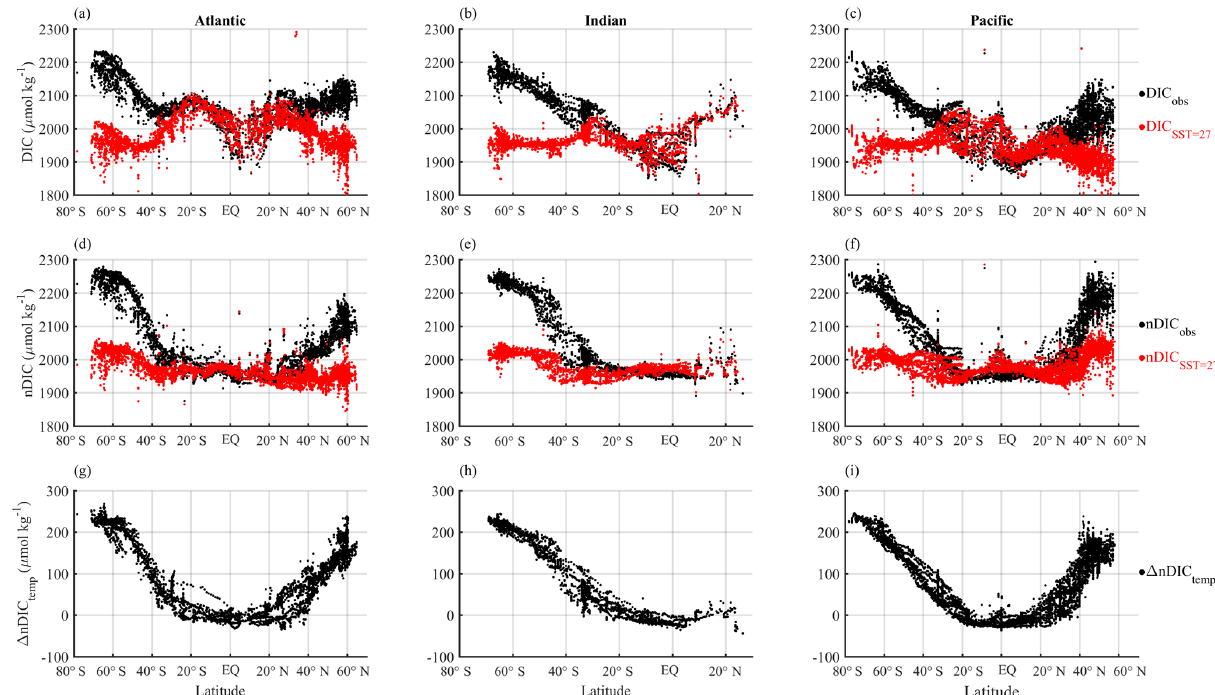
Figure 7. Latitudinal distributions of calculated temperature effect on surface DIC. Different columns show different basins (Atlantic, Indian, and Pacific) and different rows show different calculated DIC variables. Panels (a) , (b) , and (c) show the observed surface DIC (black) and predicted DIC at SST of 27 ◦ C (red). Panels (d) , (e) , and (f) show the observed surface nDIC (black) and predicted nDIC at SST of 27 ◦ C (red). Panels (g) , (h) , and (i) show (cid:49) nDIC temp , where nDIC SST = 27 is subtracted from nDIC obs to obtain the calculated temperature effect.